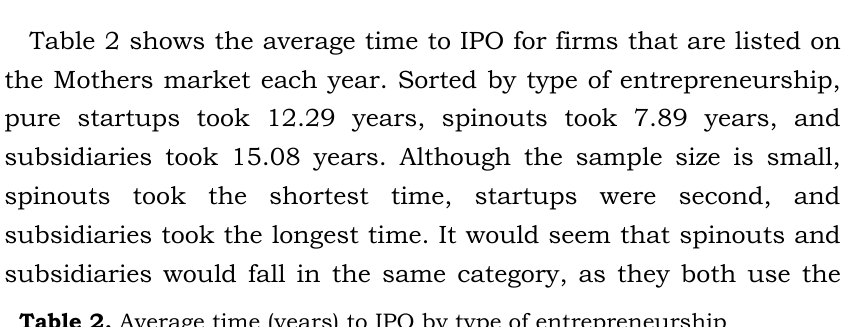
Table 2. Average time (years) to IPO by type of entrepreneurship